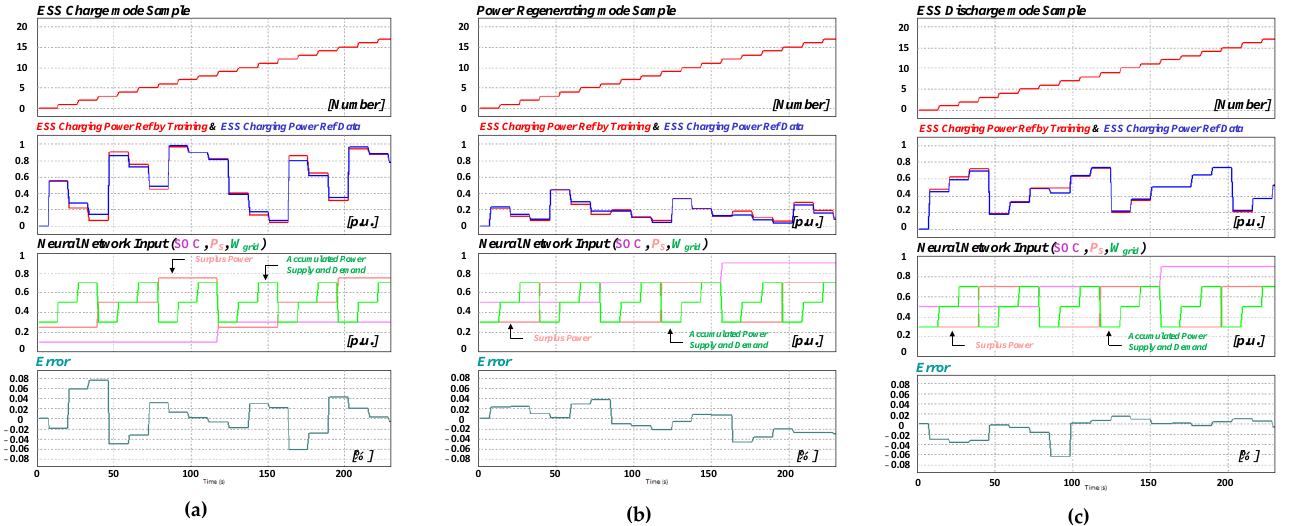
Figure 13. Simulation results of ANN training ( a ) ESS charge mode, ( b ) power regeneration mode, ( c ) ESS discharge mode.